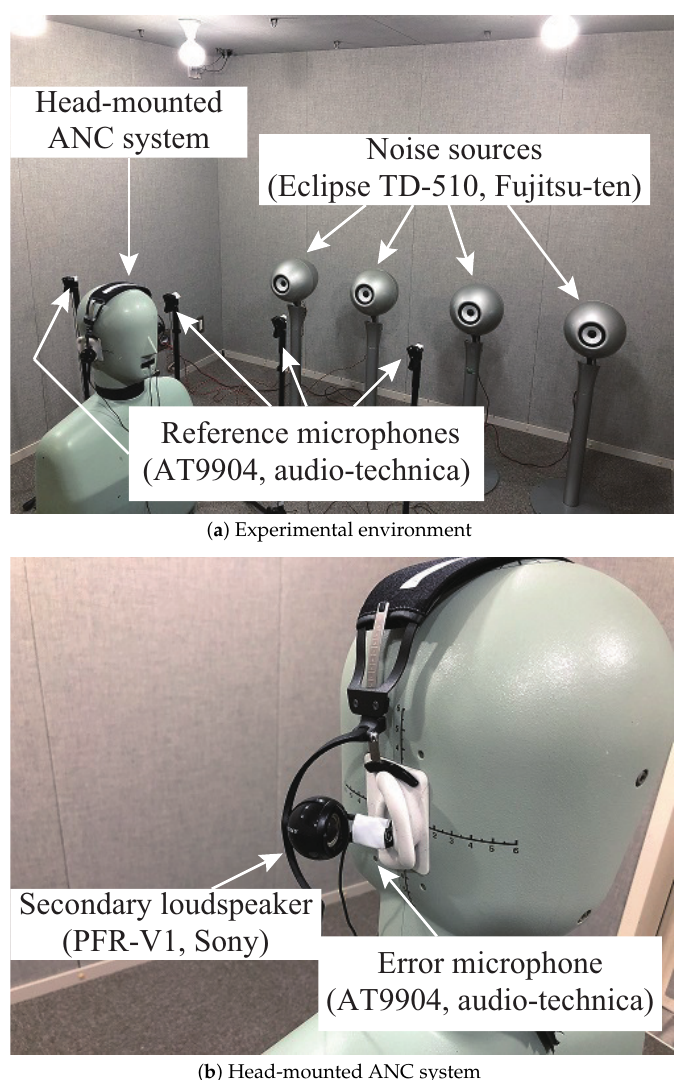
Figure 8. Pictures of the experimental